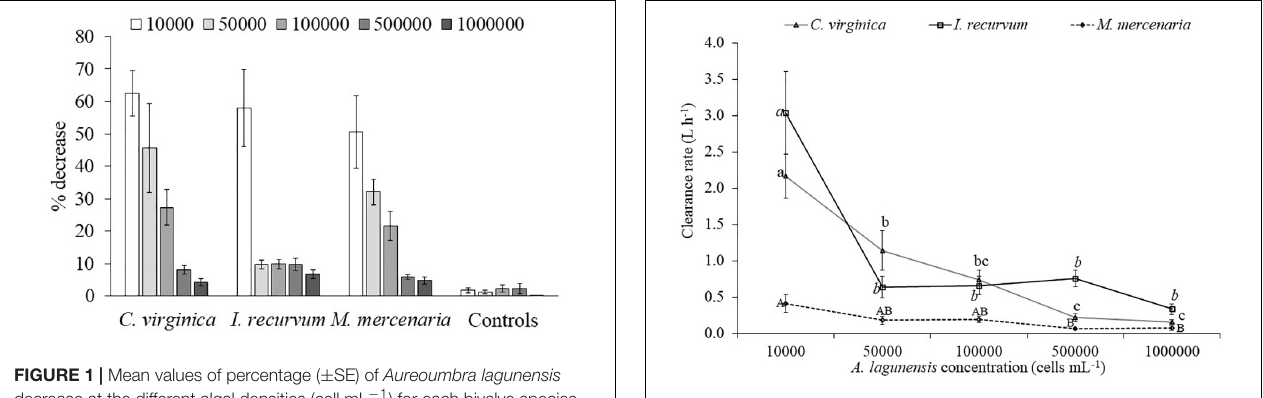
FIGURE 2 | Mean values for the clearance rates ( ± SE) for each bivalve species ( Crassostrea virginica , Ischadium recurvum , and Mercenaria mercenaria ) at each brown tide concentration. Letters indicate significant differences for the one-way ANOVA for each species comparing the clearance rates at the different brown tide concentrations (lowercase for Crassostrea virginica , lowercase italics for Ischadium recurvum , capital letters for Mercenaria mercenaria ).